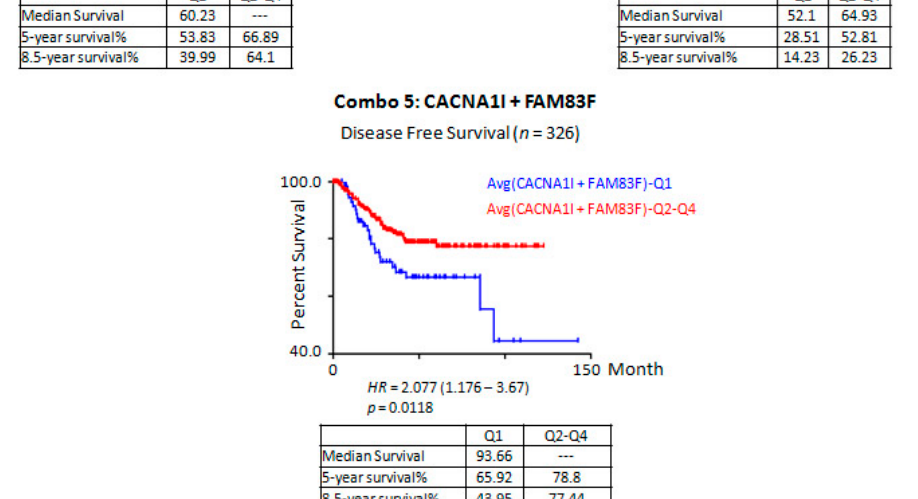
Figure 2. Five different combinations (Combo 1-5) of candidate tumor suppressor genes consistently consolidated their association with disease specific survival (OS), and disease free survival (DFS) in CRC samples’ expression data. Q1–Q4 signify expression quartiles with Q1 being the lowest and Q4 the highest expression quartile.